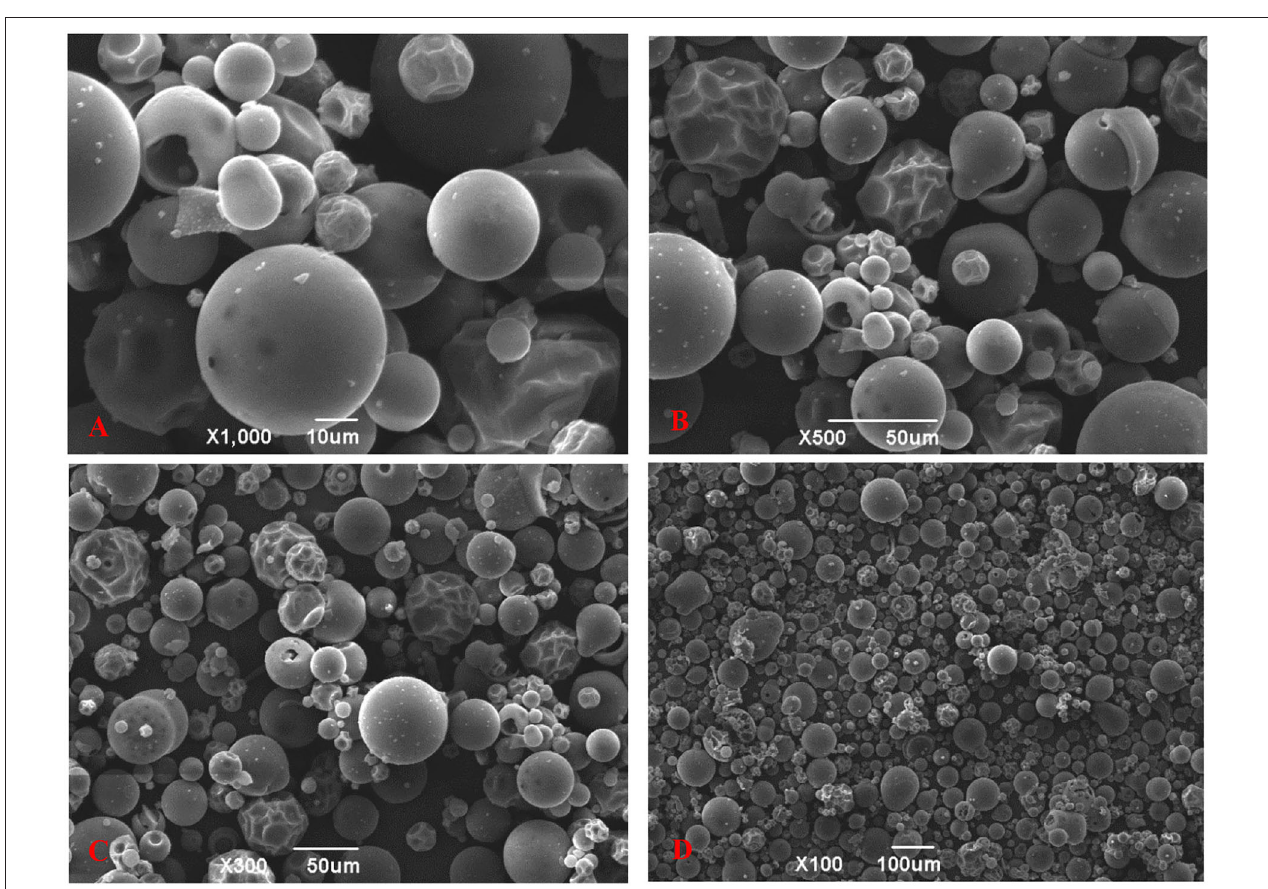
FIGURE 4 | Scanning electron microscopy (SEM) micrographs of TBs-E; (A) zoom in 1,000X (10 µ m), (B) zoom in 500X (50 µ m), (C) zoom in 300X (50 µ m), and (D) zoom in 100X (100 µ m).